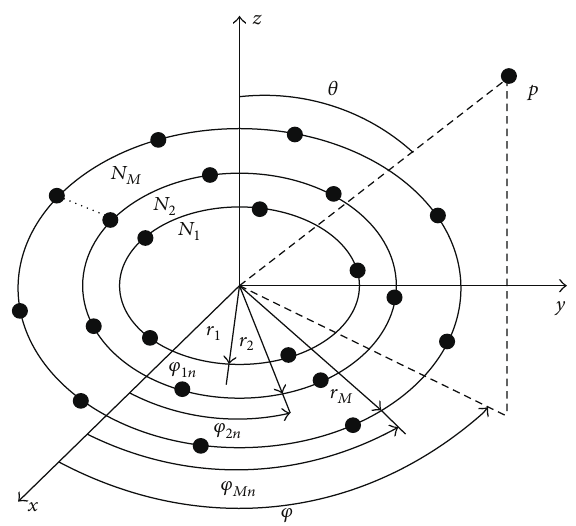
Figure 1: Geometry of concentric circular antenna